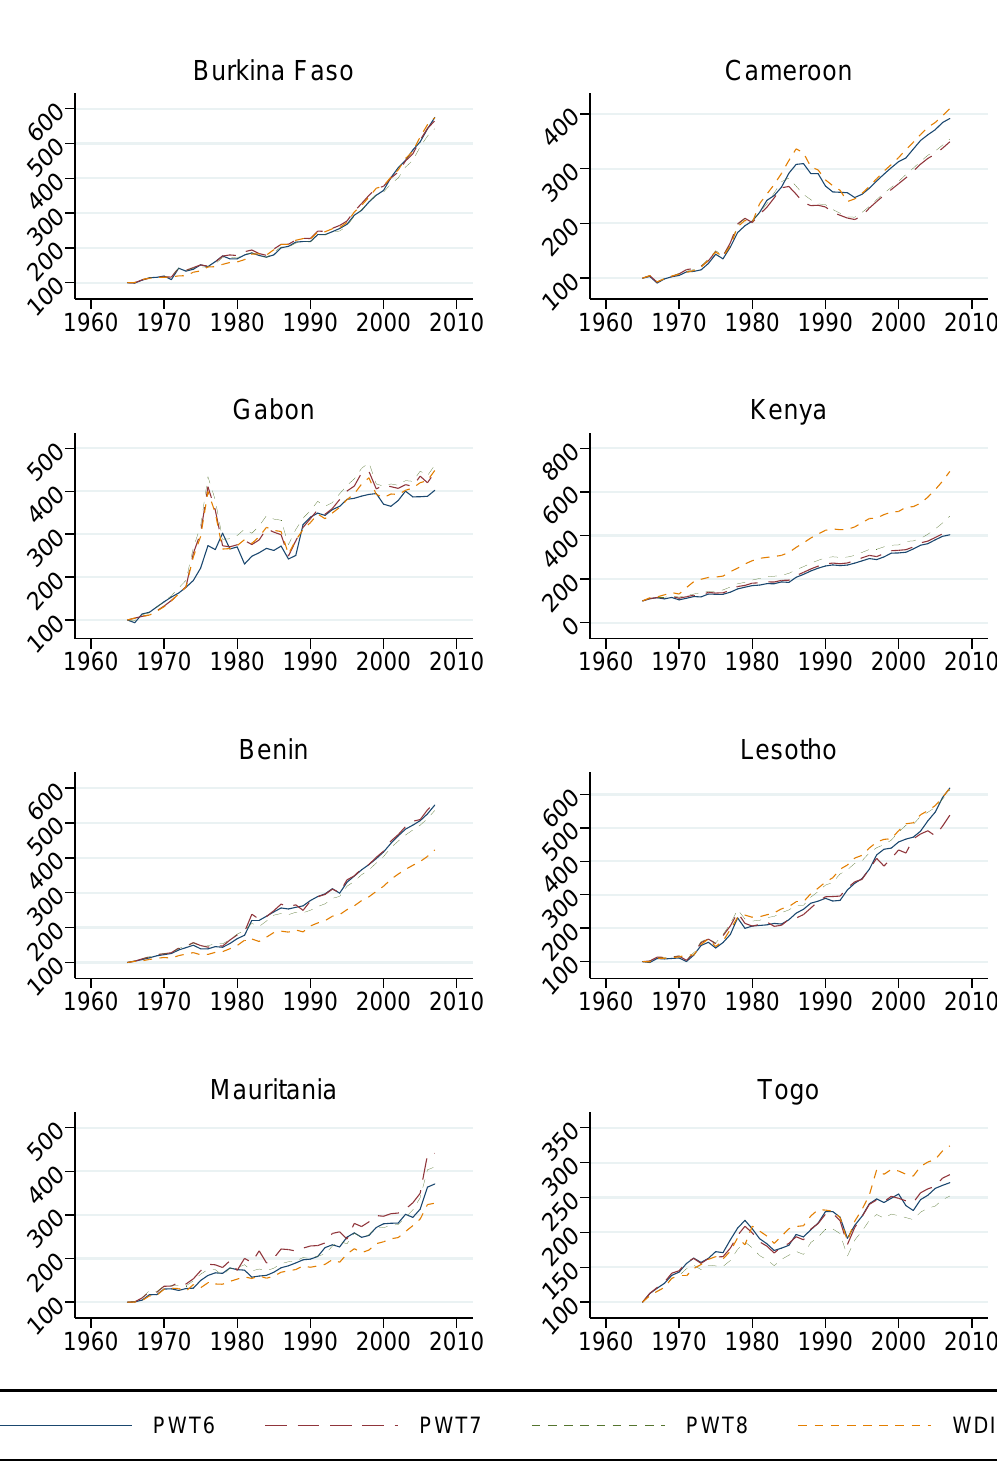
Figure 1: GDP series from four sources, normalised to 1965